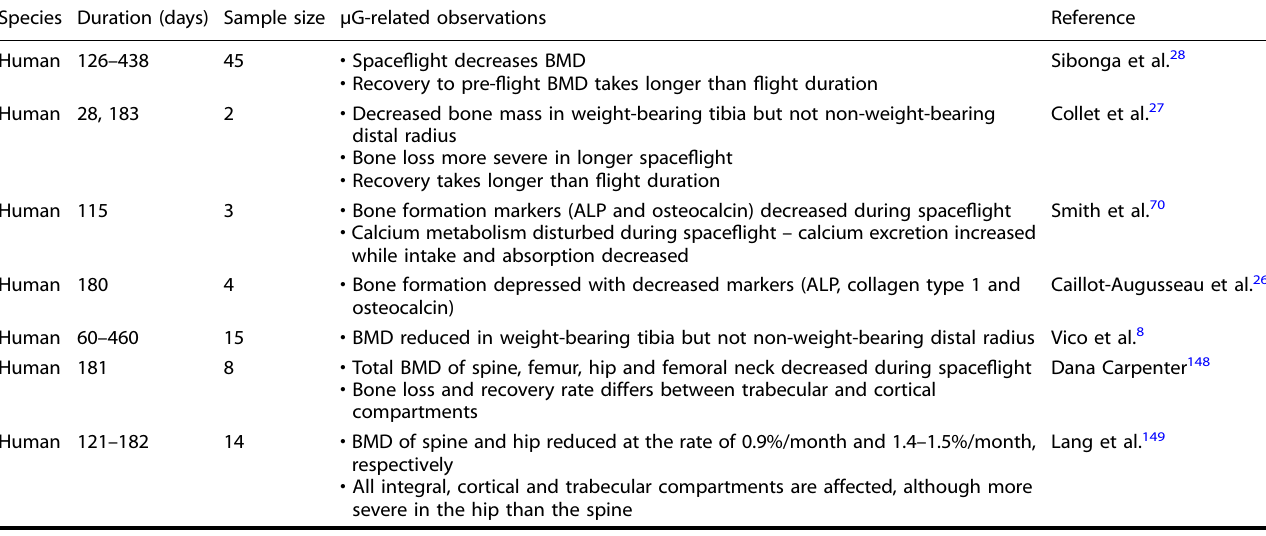
Table 1. Space fl ight studies of bone-loss in humans. Species Duration (days) Sample size µG-related